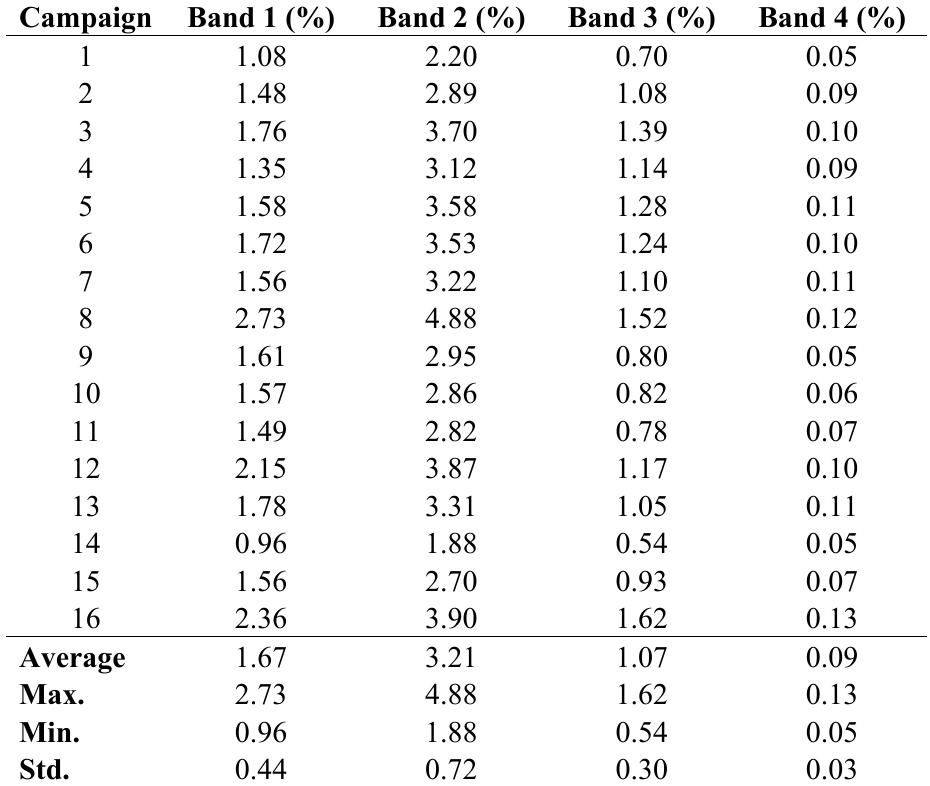
Table 4. Spectroradiometric measurements over the Asprokremmos